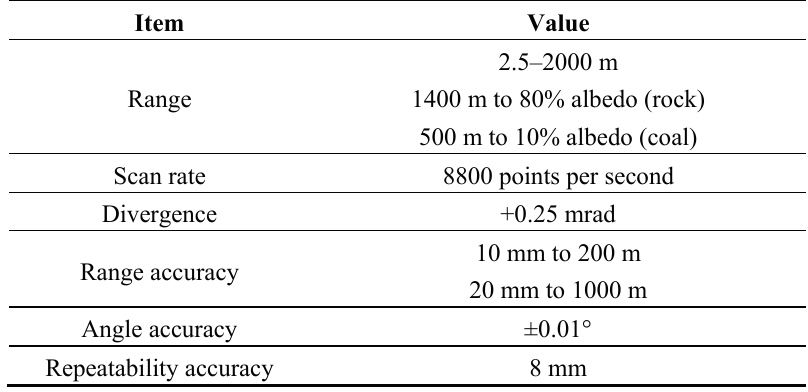
Table 2. Technical specifications of the TLS used in the